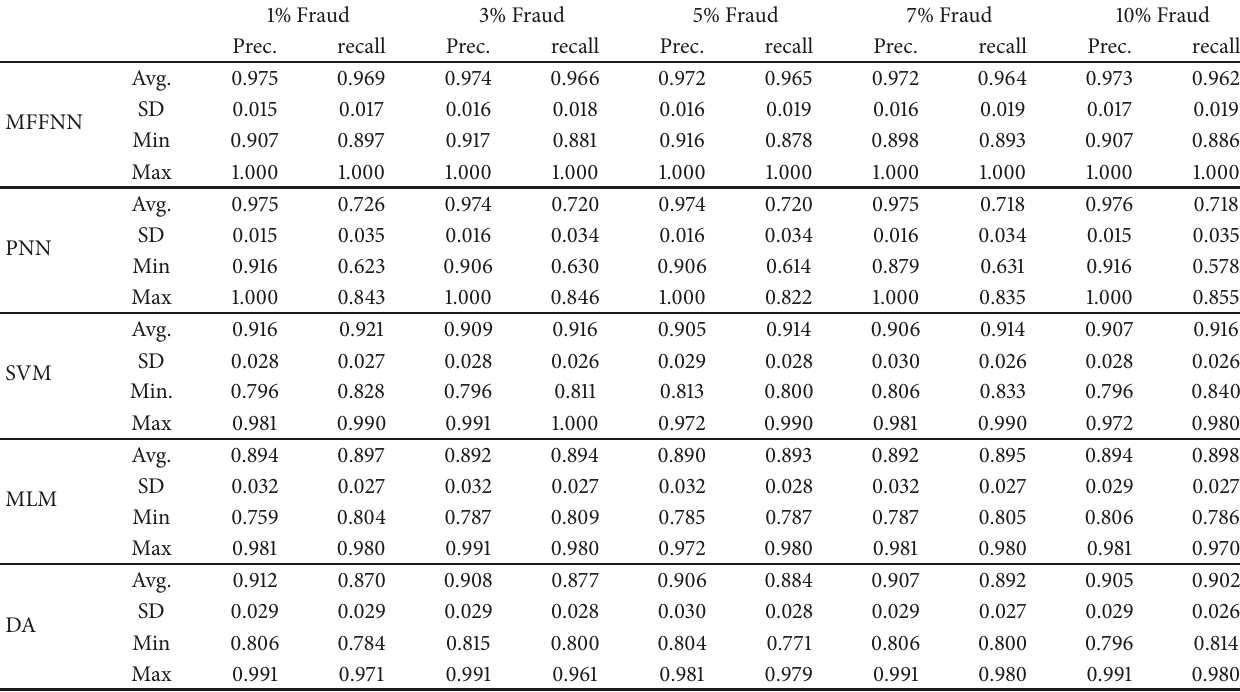
Table 6: Descriptive statistics of the performance measures obtained from 1000 iterations segmented by different rate of fraudulent companies, and for training sample size of 800 and test sample size of 270.